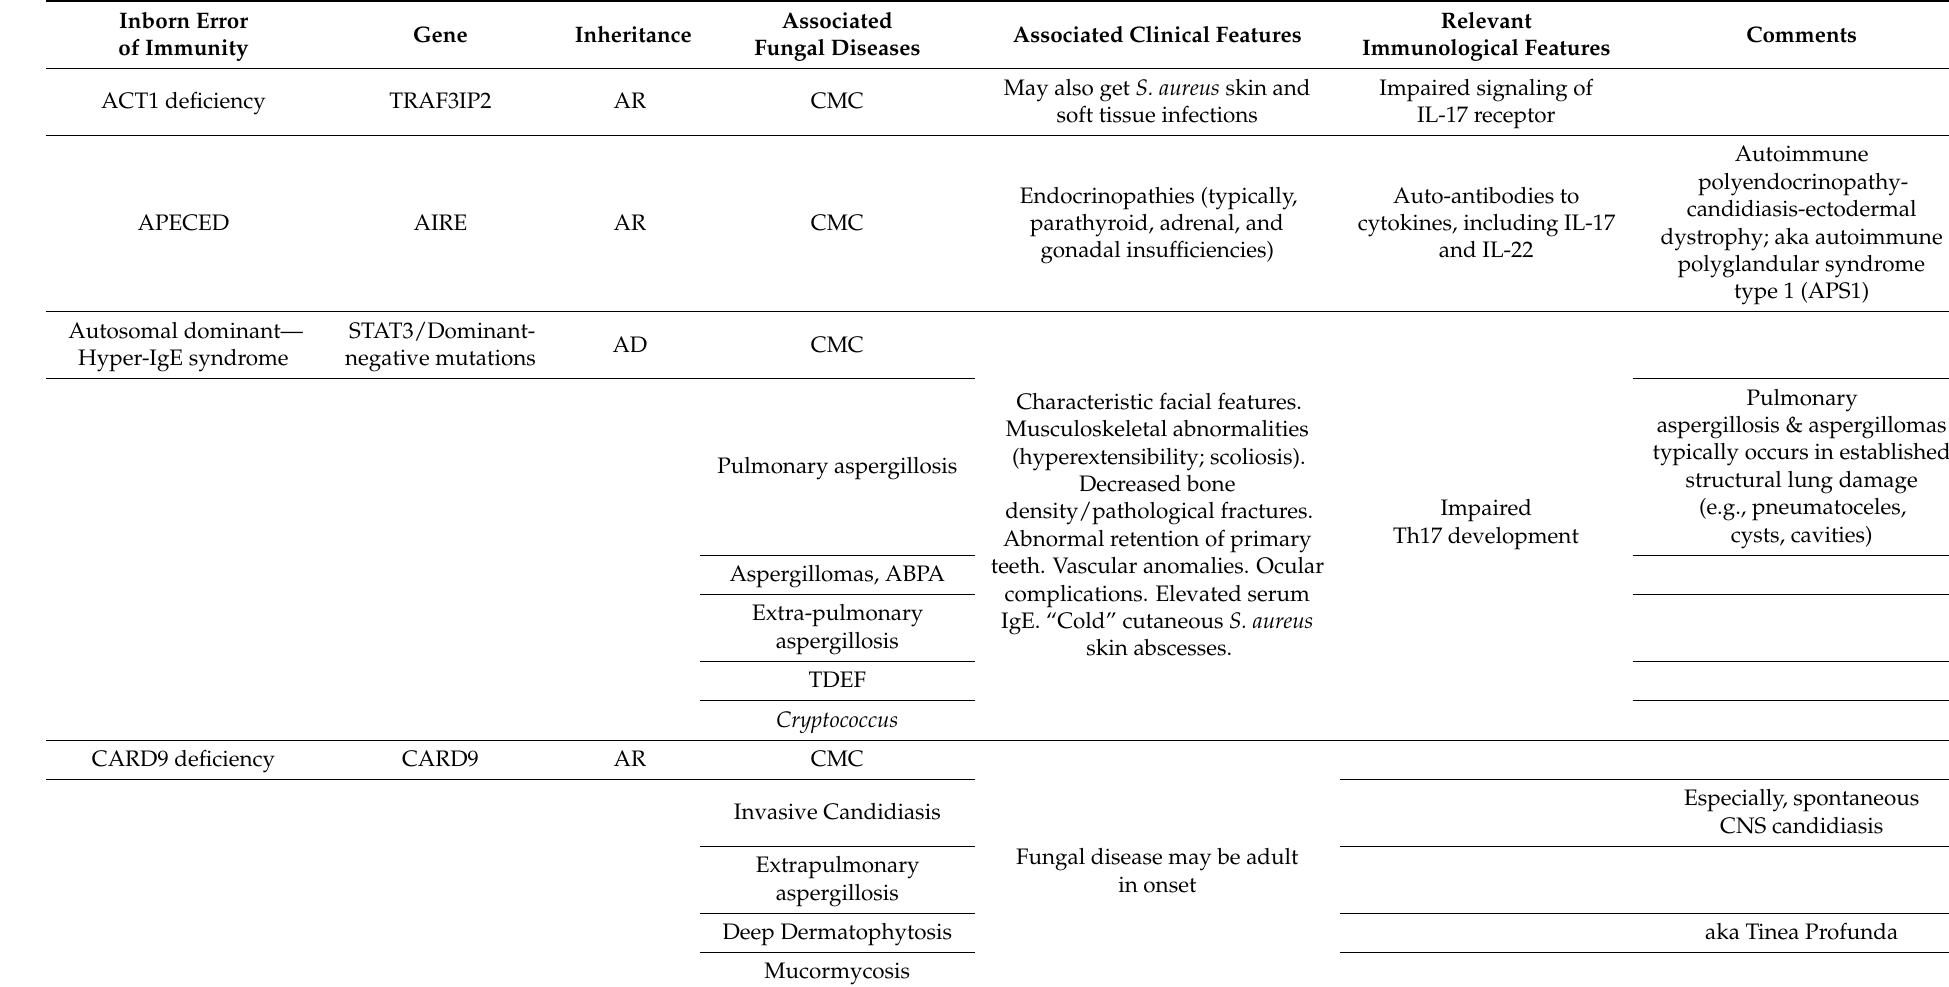
Table 1. The IEI discussed in this review are